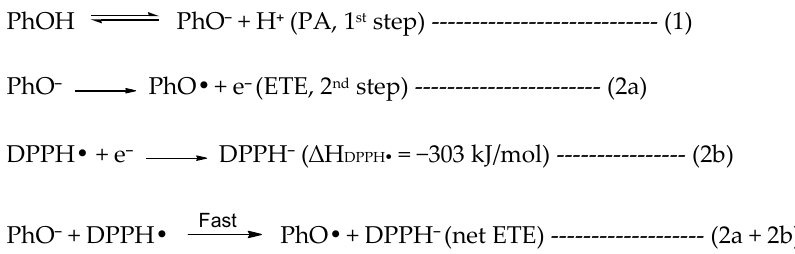
Table 4. Calculated electron transfer enthalpy (ETE) values (kJ/mol) of the phenol rings (X, X’ and Y) in